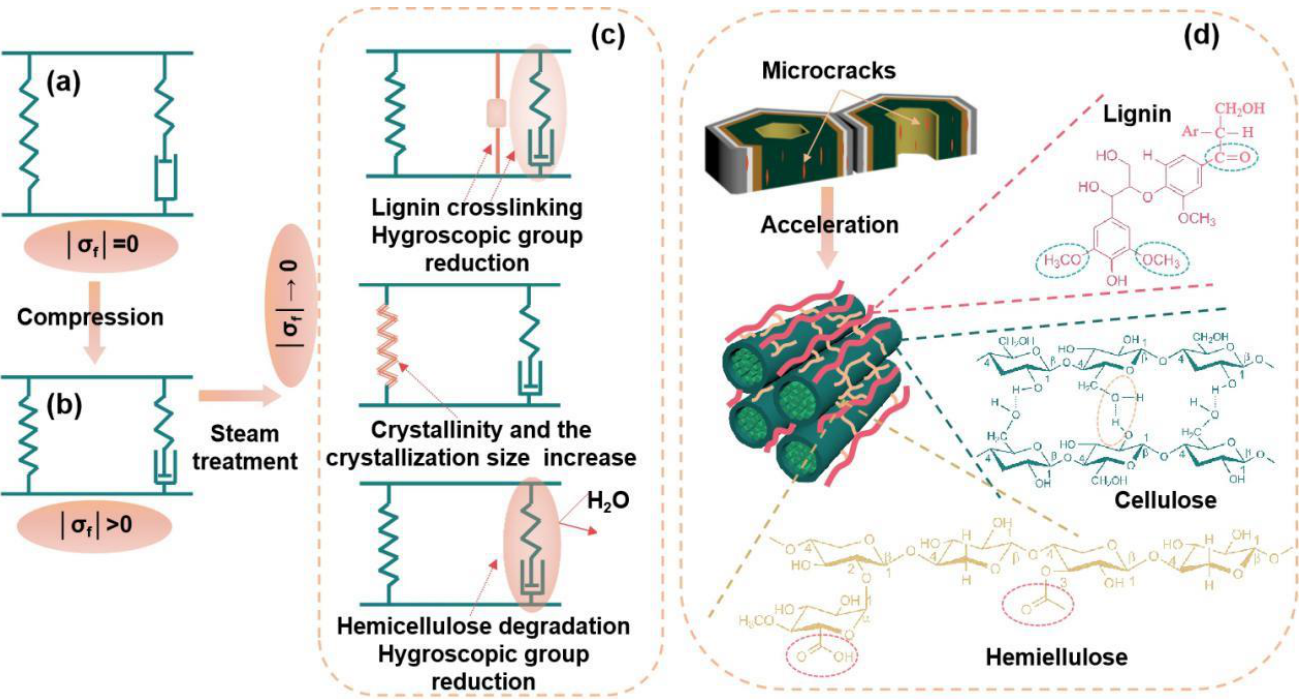
Figure 8. Schematic diagram of the influence mechanism of pressurized superheated steam treatment on the dimensional stability of surface-compressed wood. ( a – c ) are the spring–dashpot model of control wood, SCW , and SCW + PHT; ( d ) is microstructure and chemical changes of SCW + PHT.